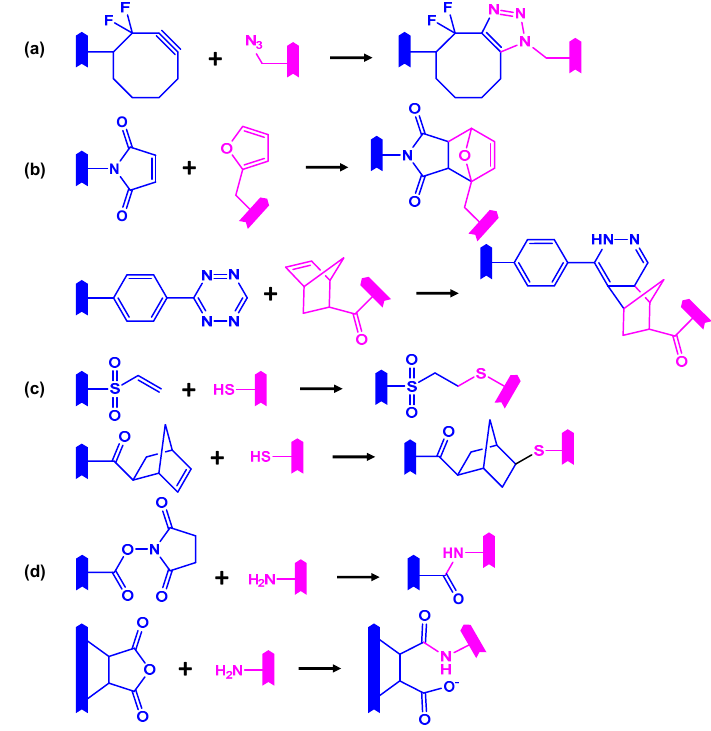
Figure 2. Selected conjugation reactions used for chemical cross-linking of macromers with corresponding functional groups (blue and magenta). The symbol represents an oligomer segment that contains a functional group. ( a ) Strain-promoted metal-free cycloaddition of a difluorocyclooctyne with an azide; ( b ) Diels-Alder cycloaddition of a maleimide with a furane and below an Inverse electron demand Diels–Alder reaction of a tetrazine with a norbornene; ( c ) Thiol- ene reaction of a vinyl sulfone with a thiol through a Michael addition mechanism and below a free- radical thiol-ene addition of a thiol to a norbornene; ( d ) Amide formation of a primary amine with a succinimide ester or a cyclic anhydride (below).